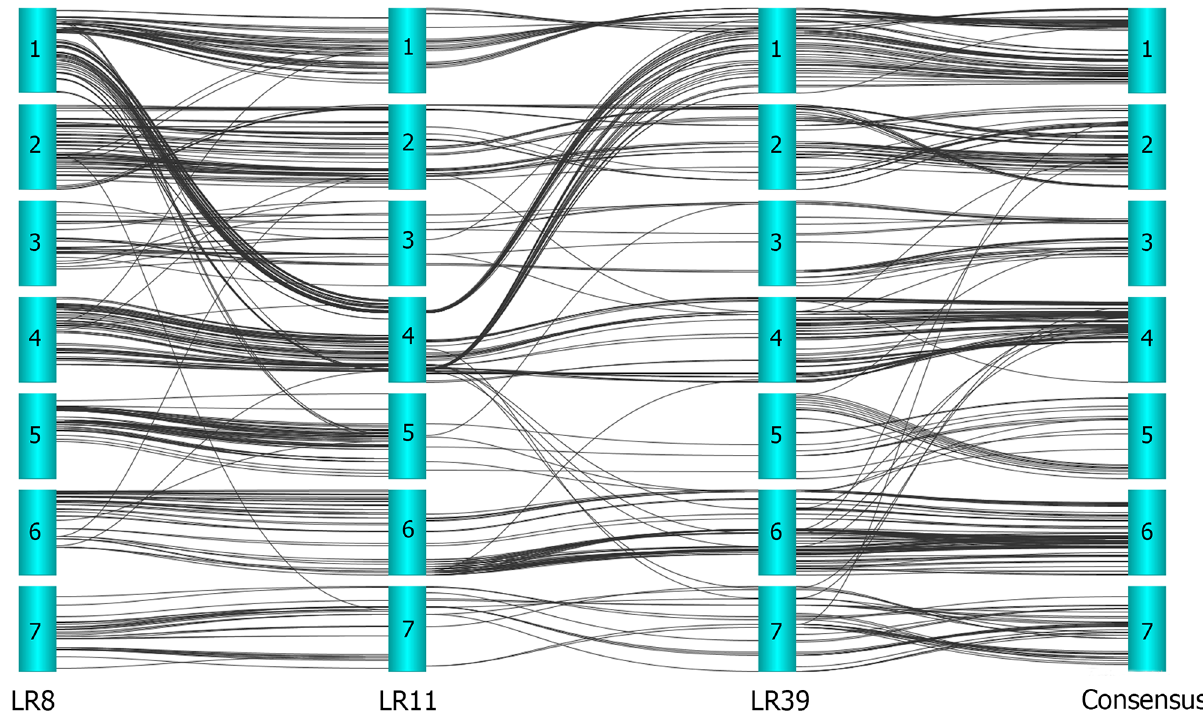
Fig 2. Comparison of linkage groups from the consensus map and component maps.